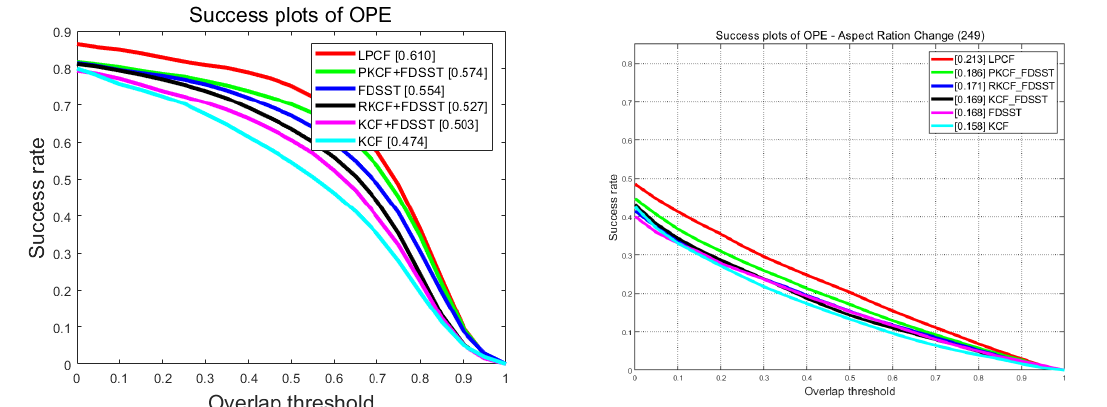
Figure 2. The success plots of OPE on OTB-2015 ( Left ) and LASOT ( Right ). The numbers in the legend indicate the area-under-the-curve (AUC) score. The code of KCF and FDSST is provided by the original authors. The LASOT pre-computed results of KCF and FDSST are provided by the LASOT authors. We recommend checking this figure in color.